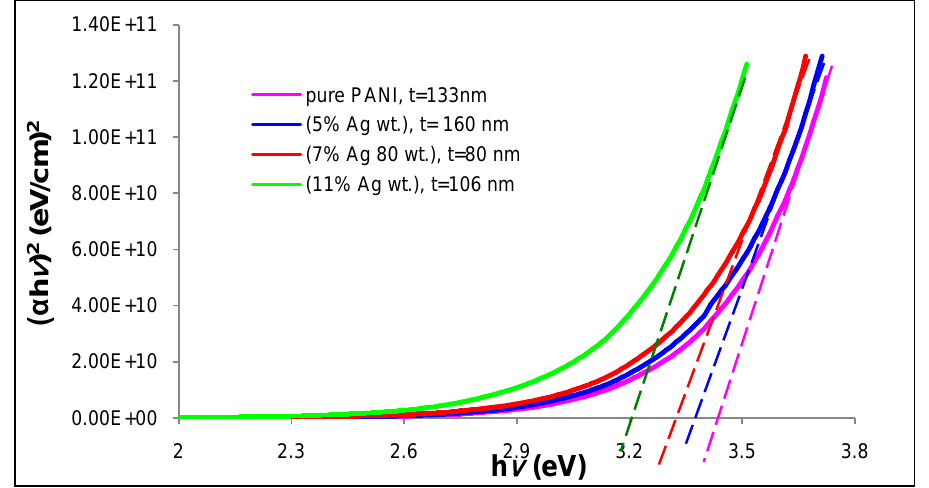
Fig.5: Variation of (